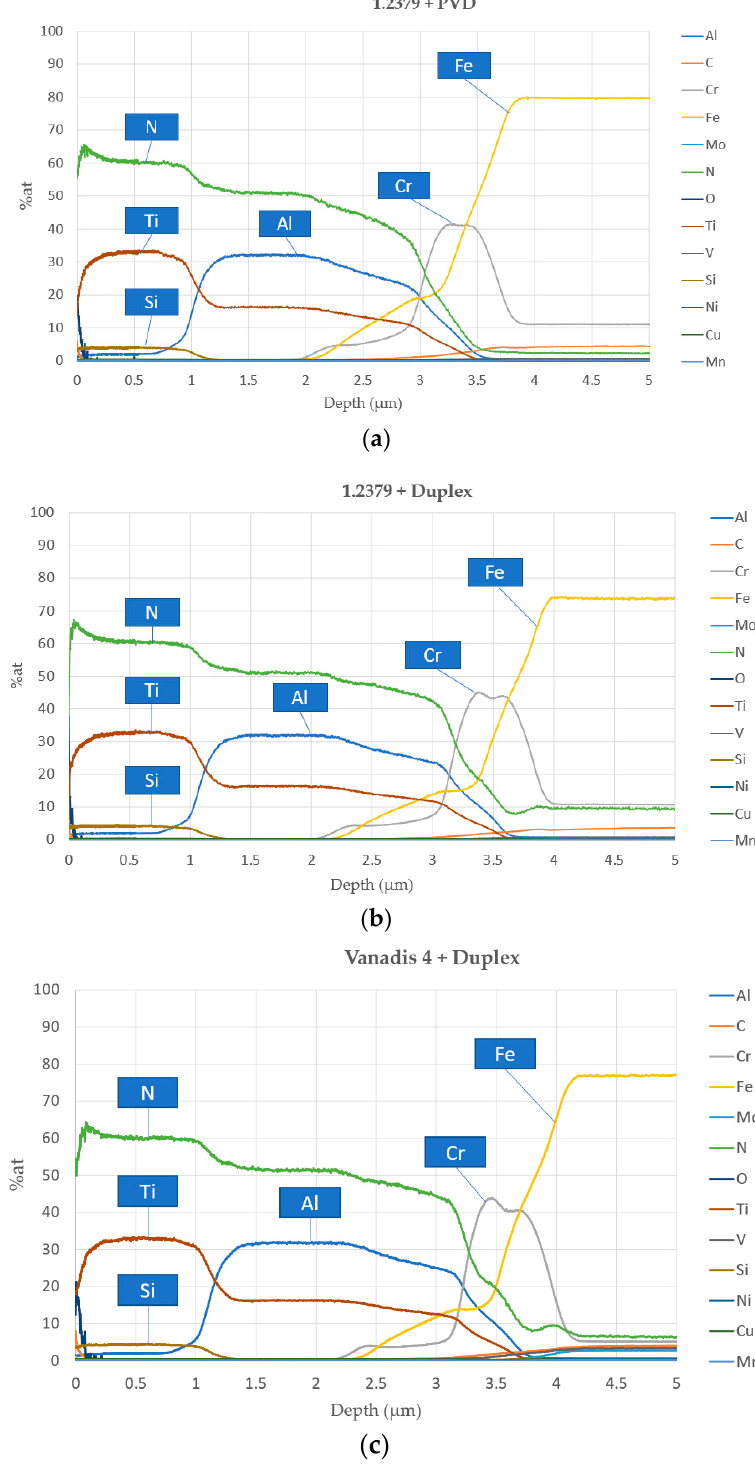
Figure 1. Glow discharge optical spectrometry (GD-OES) concentration profiles in the 1.2379 + PVD ( a ), 1.2379 + Duplex ( b ), and Vanadis 4 + Duplex ( c ) samples.